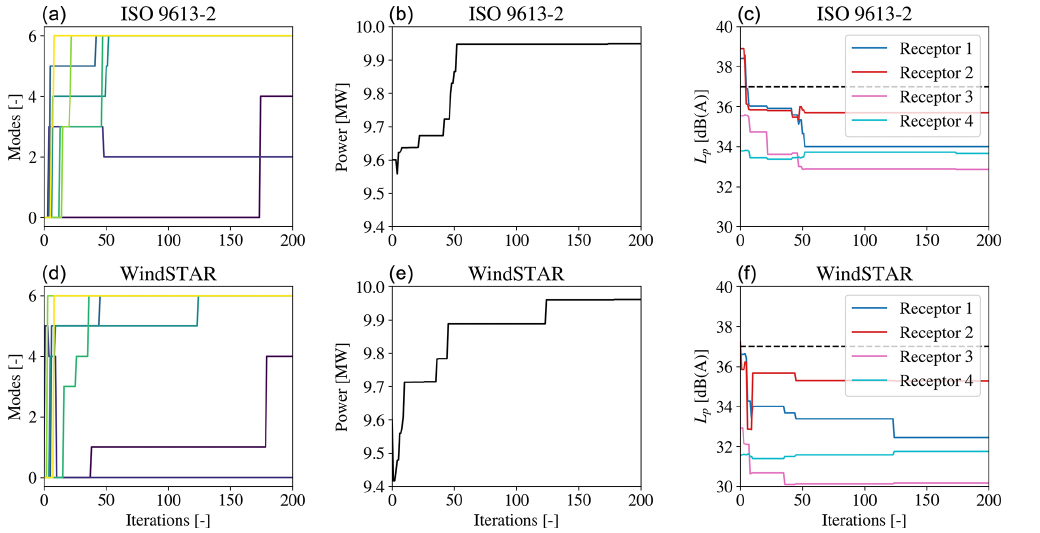
Figure 14. The operational mode, m i , for each wind turbine (a, d) ; the overall power of the seven SWT-DD-142 wind turbines (b, e) ; and the integrated sound pressure level, U hub = 10ms − 1 , at each receptor (c, f) during the optimization at θ = 225 ◦ and U 0 = 10ms − 1 . The noise constraint is set to L p , lim ,j = 37dB(A) and represented by the dashed line in the right